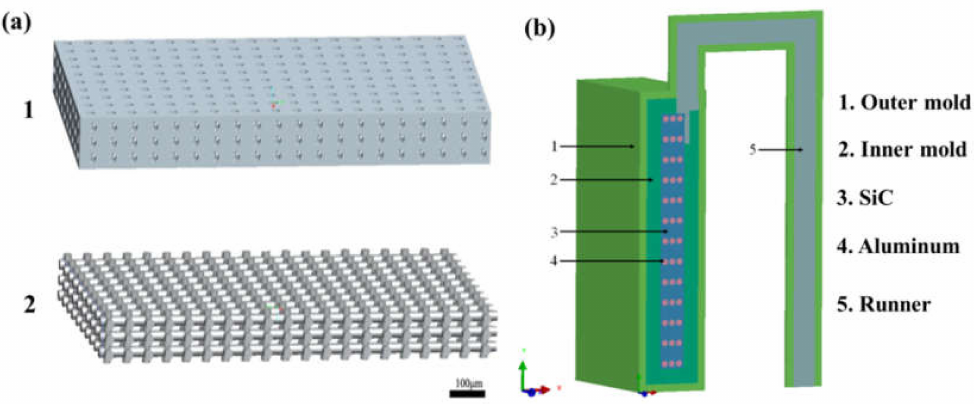
Figure 1. ( a ) SiC/Al composite material model (a-1), simplified SiC model (a-2), and simplified aluminum alloy model. ( b ) Three–dimensional model